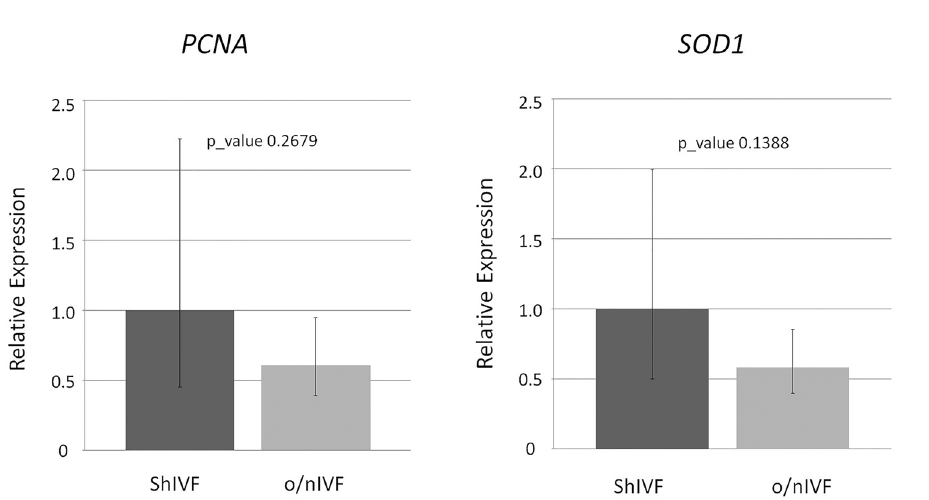
Figure 4. Analysis of molecular markers. The relative expression of the Proliferating Cells Nuclear Antigen (PCNA) and the antioxidant gene (SOD1) were investigated in shIVF and o/nIVF groups (n = 3 each) by RT-qPCR. ACTB were used as reference genes. Gene relative expressions and P-Value (t-test) between shIVF and o/nIVF groups were calculated by the PCR R